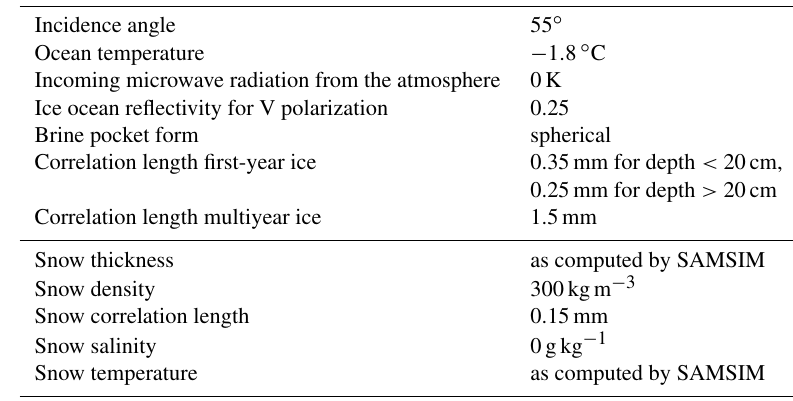
Figure 2. Evolution of sea ice (solid line) and snow (dashed line) thickness as simulated by SAMSIM under ERA-Interim forcing between July 2005 and December 2009. We use ERA-Interim forcing from 75 ◦ N, 0 ◦ W for the first-year ice and from 90 ◦ N for multiyear ice. Note that to avoid unrealistic model artifacts in the ice thickness, we have masked out the few timesteps following the final phase of the melting of the snow cover. Also note that the same analysis was conducted using atmospheric forcing from the points 74 ◦ N, 170 ◦ E; 77 ◦ N, 39 ◦ E; 80 ◦ N, 160 ◦ W; 82 ◦ N, 120 ◦ W; and 85 ◦ N, 50 ◦ W (not shown) to ensure the robustness of our results. Table 1. MEMLS constant input details and properties of the snow layer. The incidence angle is from AMSR-E and AMSR2, which are passive microwave sensors measuring at 6.9GHz (NASDA, 2003; JAXA, 2011). The ocean temperature and snow density are the constant values used in a GCM such as MPI-ESM (Wetzel et al., 2012; Giorgetta et al., 2013). The incoming microwave radiation from the atmosphere is set to 0K because we want to focus on the effect of sea ice properties on the emitted radiation. Correlation lengths are based on past experiments conducted by Rasmus T.